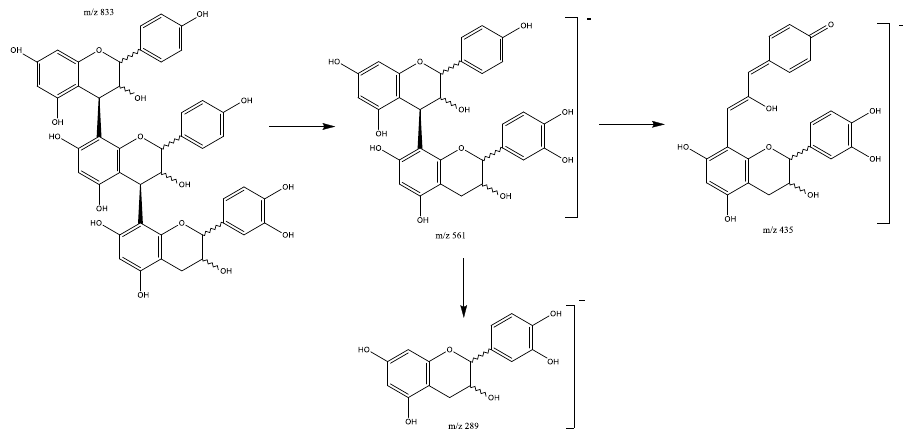
Figure 9. Propelargonidins (epi)afzelechin-(epi)afzelechin-(epi)catechin B-trimers fragmentation pattern.